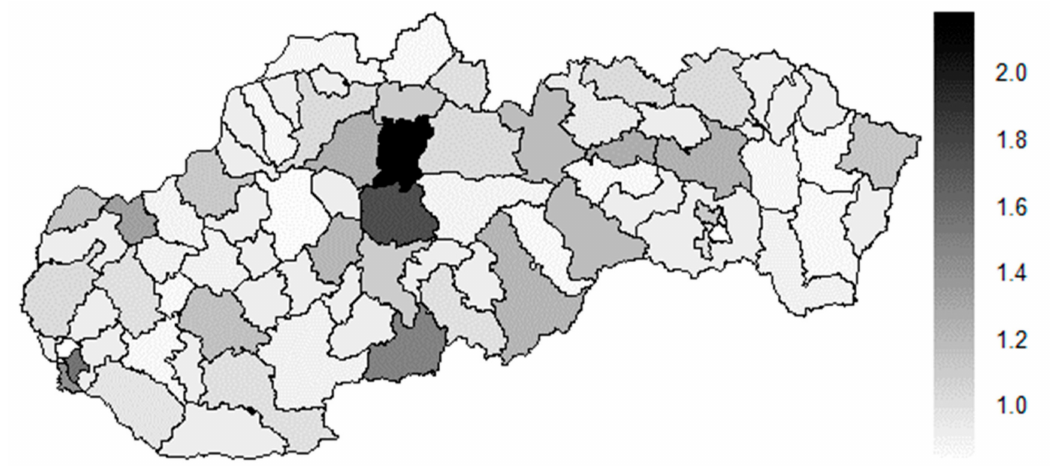
Figure 12. Modified medical equipment similarity map of the districts in the whole explored period. Source: own elaboration by the